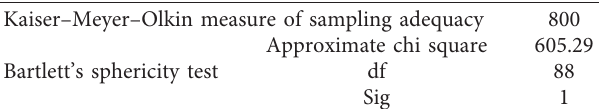
Table 3: KMO and Bartlett’s test.